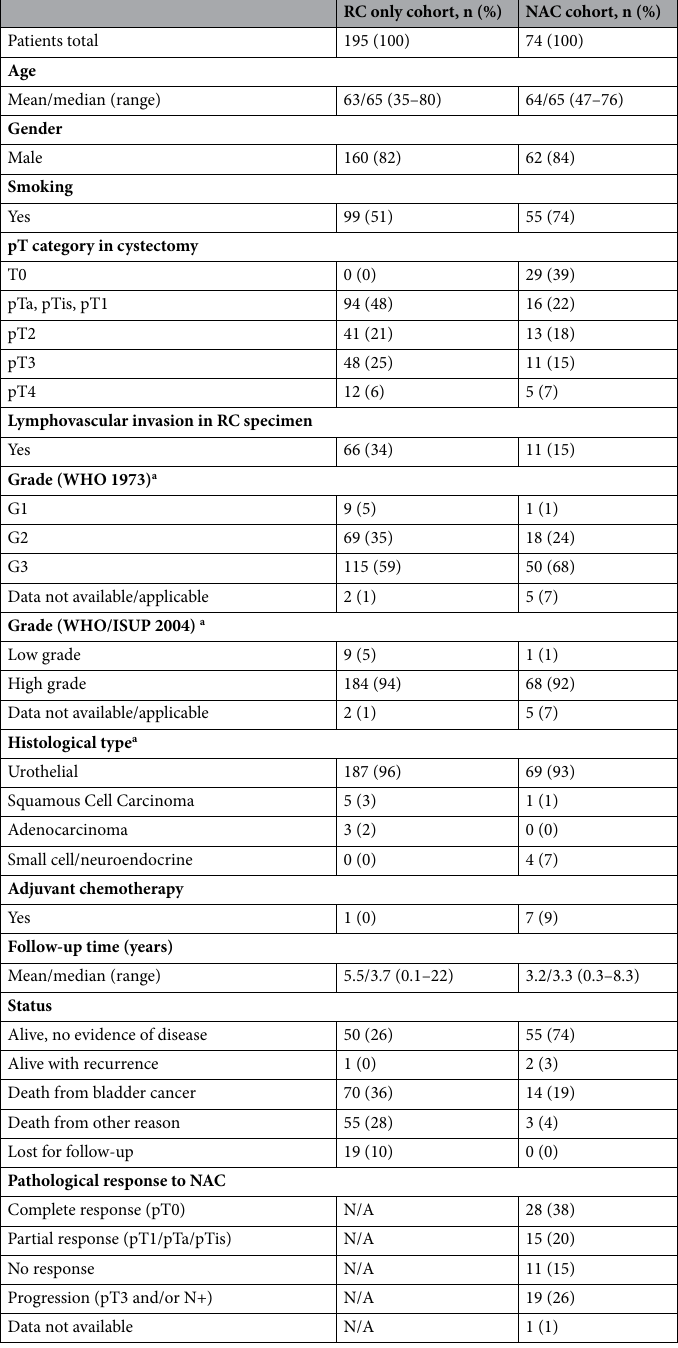
Table 1. Baseline characteristics of patients. a Based on histopathological review of cystectomy specimen for RC cohort and TUR-BT for NAC cohort,